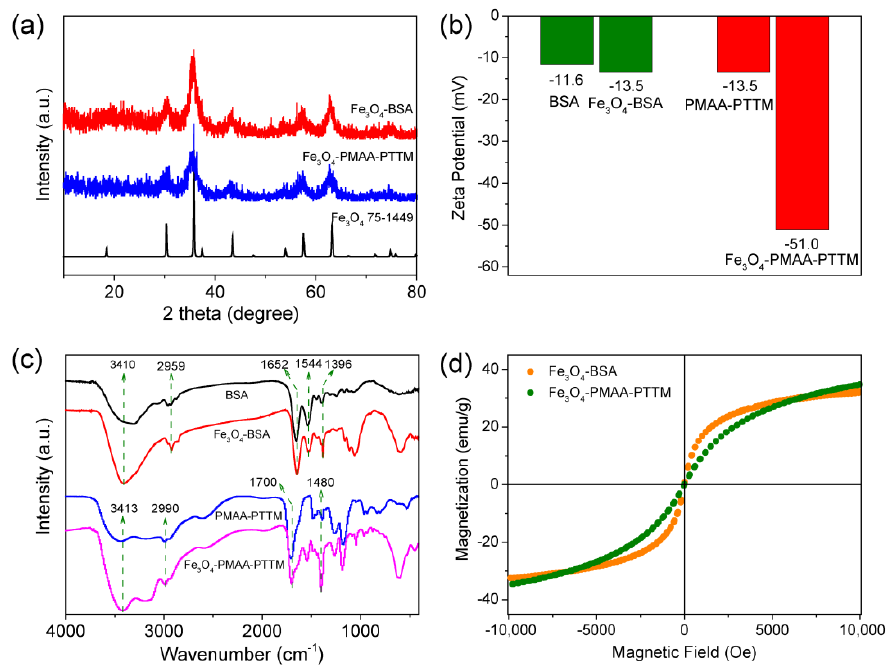
Figure 2. ( a ) Powder X-ray diffraction (PXRD) of Fe 3 O 4 -BSA (red line), Fe 3 O 4 -PMAA-PTTM (blue line) and a Fe 3 O 4 powder standard (JCPDS Card No. 75-1449, black line); ( b ) Zeta potential of BSA, Fe 3 O 4 -BSA, PMAA-PTTM and Fe 3 O 4 -PMAA-PTTM in H 2 O; ( c ) Fourier-transform infrared spectroscopy of bovine serum albumin (BSA, black line), Fe3O4-BSA (red line), PMAA-PTTM (blue line) and Fe3O4-PMAA-PTTM (purple line); ( d ) Field-dependent magnetization curves